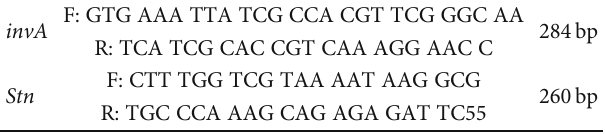
Table 1: Primer sequence and primer size used in this study.